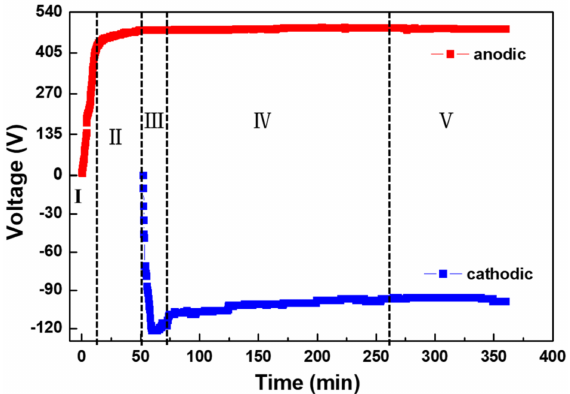
Figure 1. Voltage − time curves for the PEO